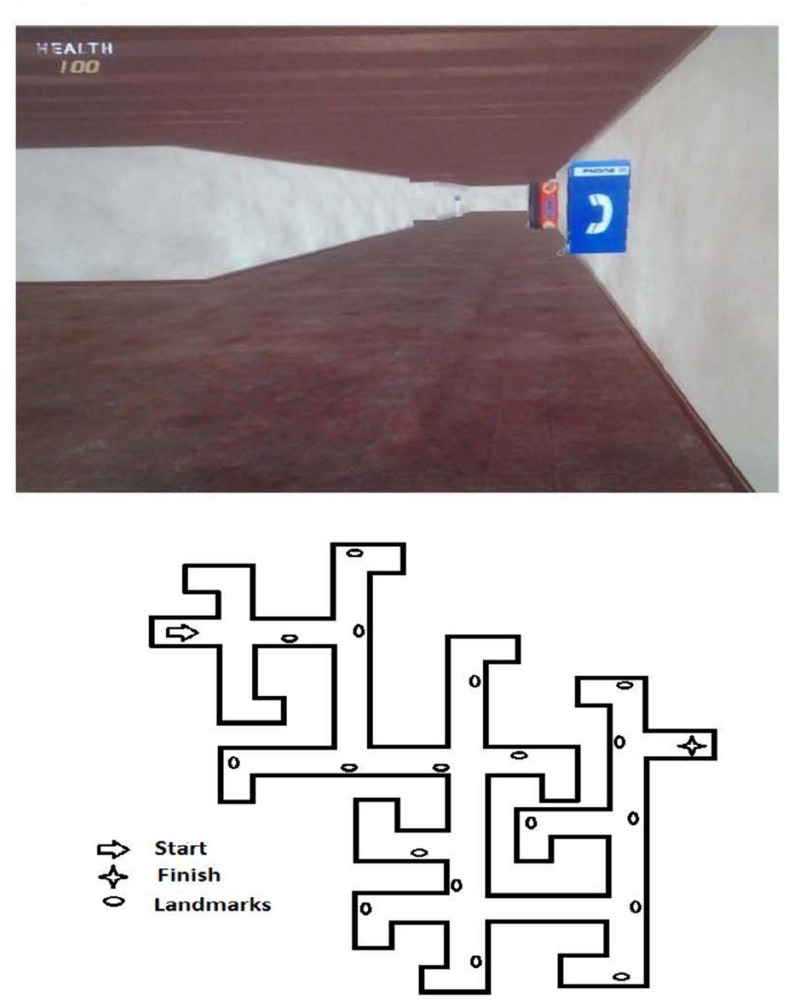
A screenshot of one segment of the route (top) and birds eye view of entire route (bottom).